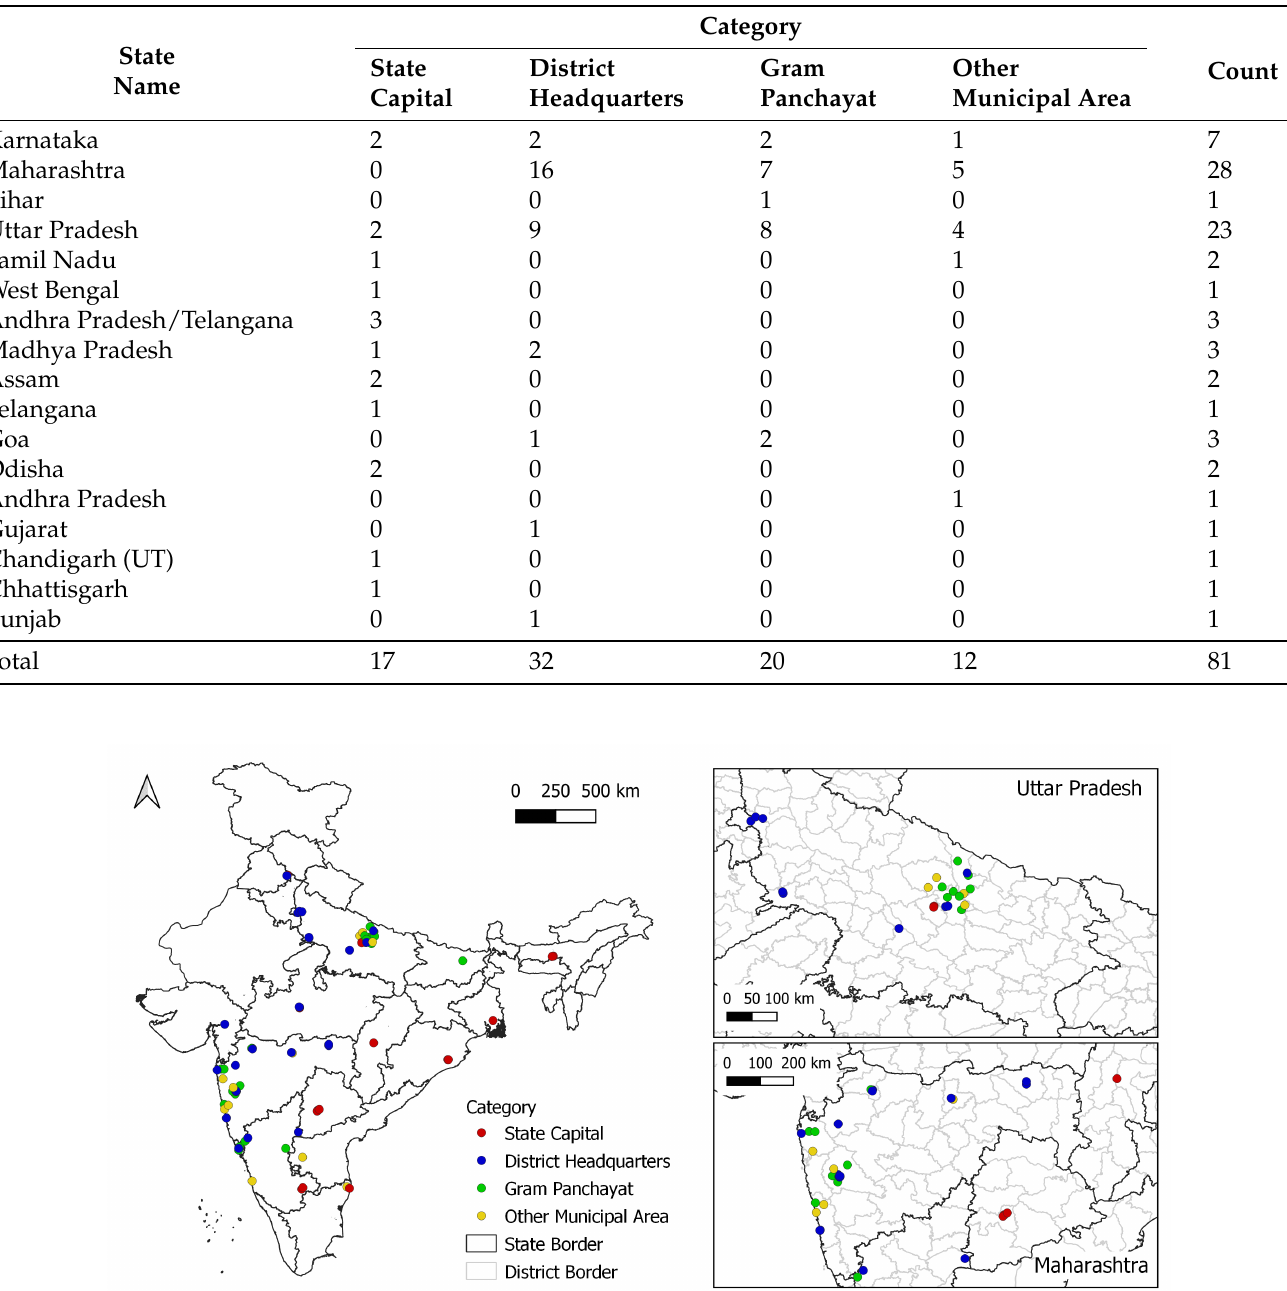
Table 2. Breakdown of voltage monitoring devices available from the Prayas Electricity Supply Monitoring Initiative (ESMI) website.